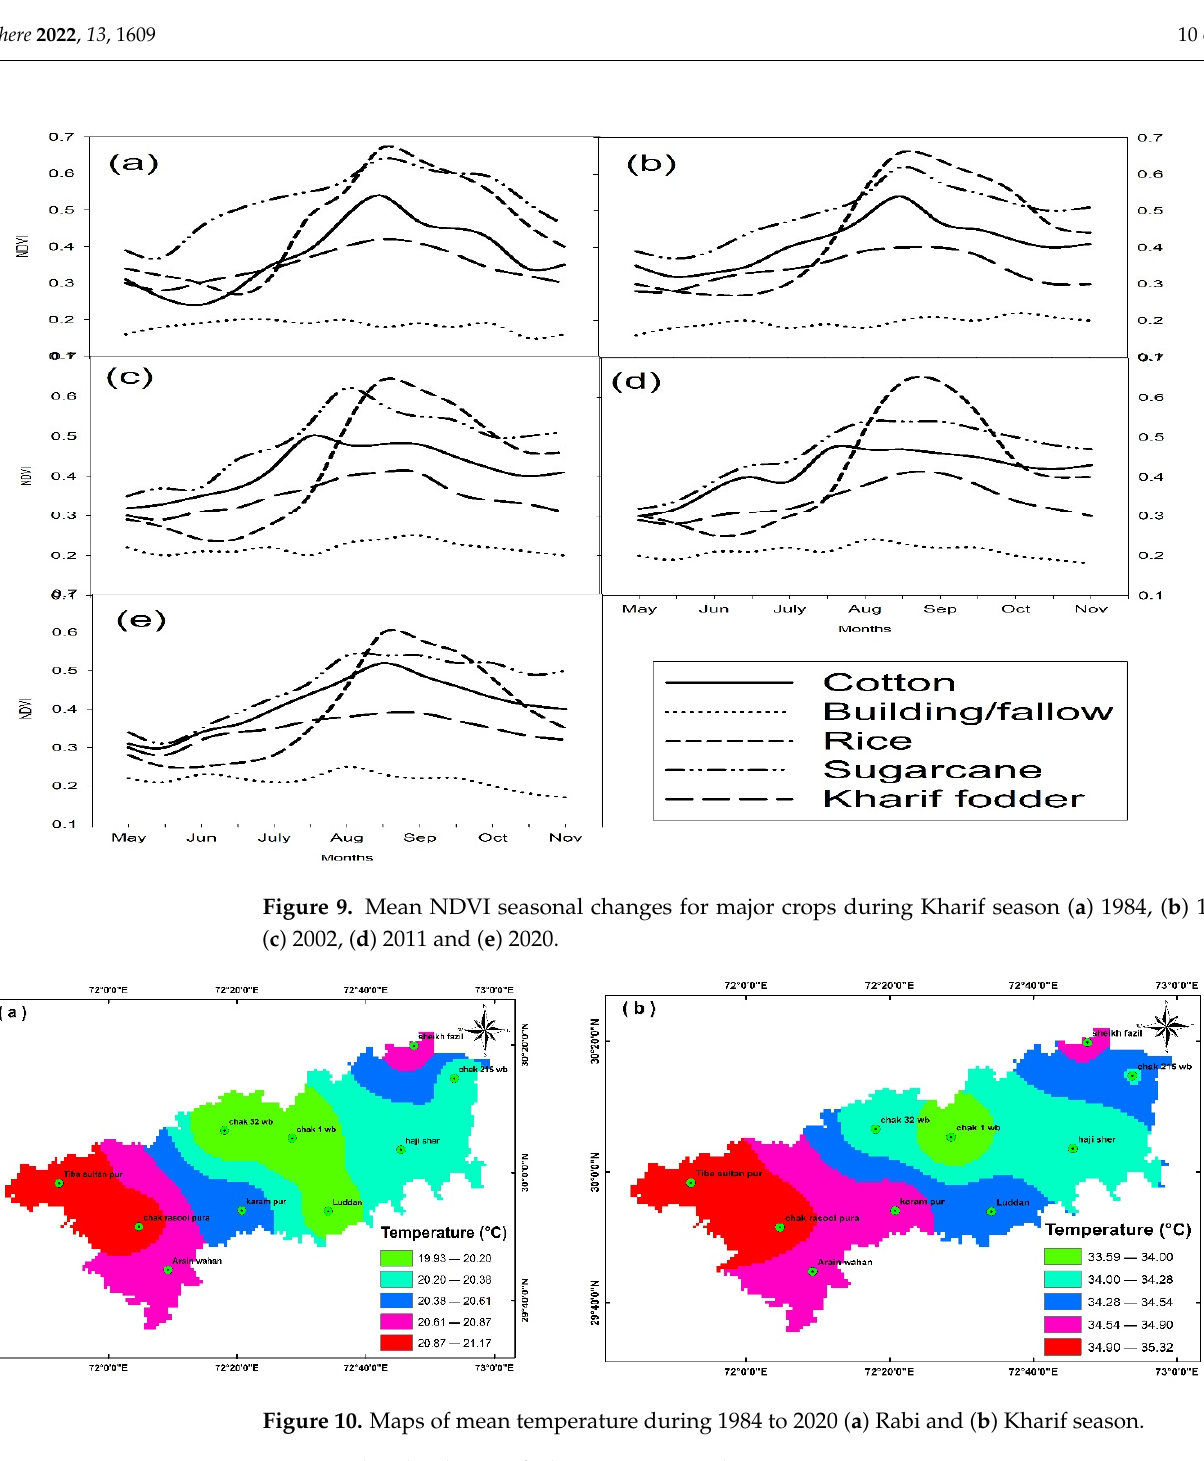
Figure 11. Maps of mean rainfall from 1984 to 2020 ( a ) Rabi and ( b ) Kharif season. 3.4. Trend and Relation of Climate Factor with NDVI Climate change significantly influences the flexibility of LULC classes in different portions of the environment. Furthermore, climate change influenced the terrestrial life strictly connected with hydrological cycles, thus affecting NDVI to a maximum amount [6].